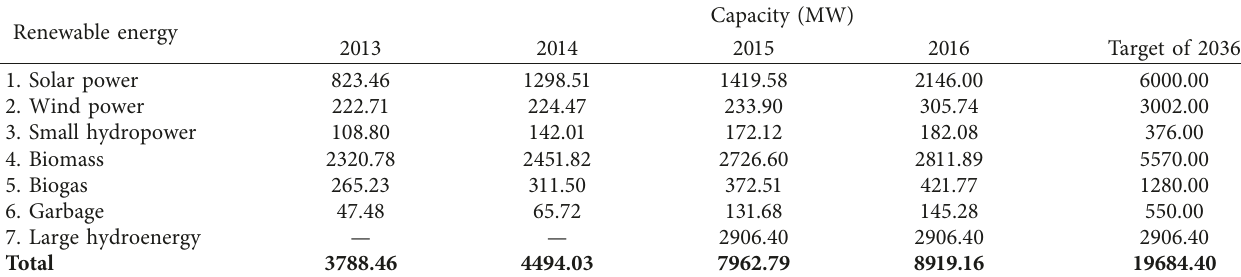
Table 1: Renewable energy capacity from 2013 to 2016 and its target in 2036 [7]. Renewable